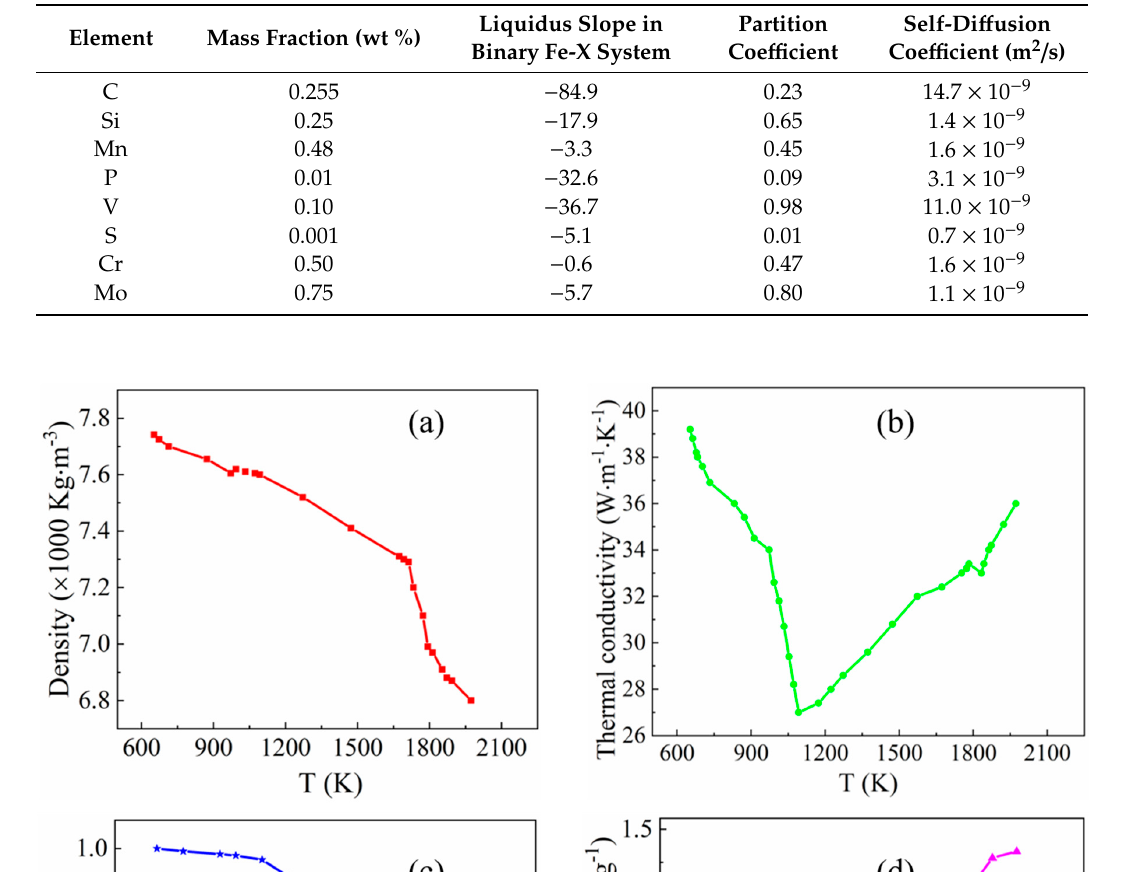
Table 2. Process parameters of the round billet continuous casting